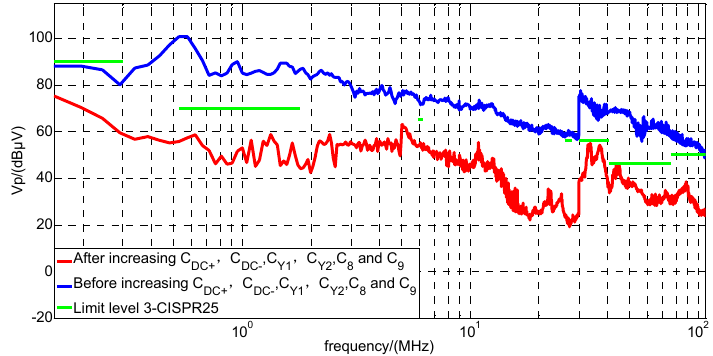
Figure 19. Positive CE voltage after C DC+ , C DC − , C Y1 , C Y2 , C 8 and C 9 were increased.